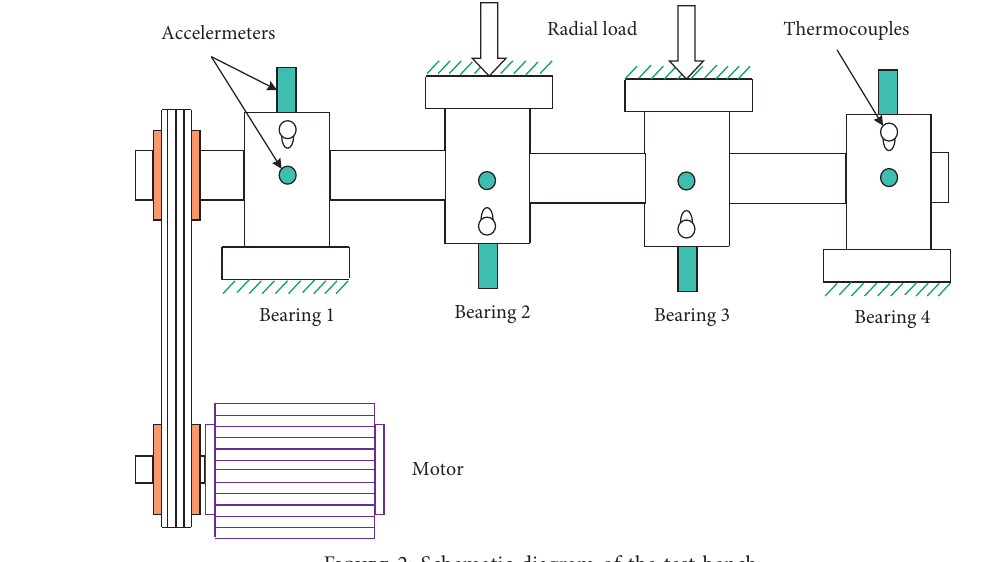
Figure 2: Schematic diagram of the test bench. Table 3: Linear weighted value of each